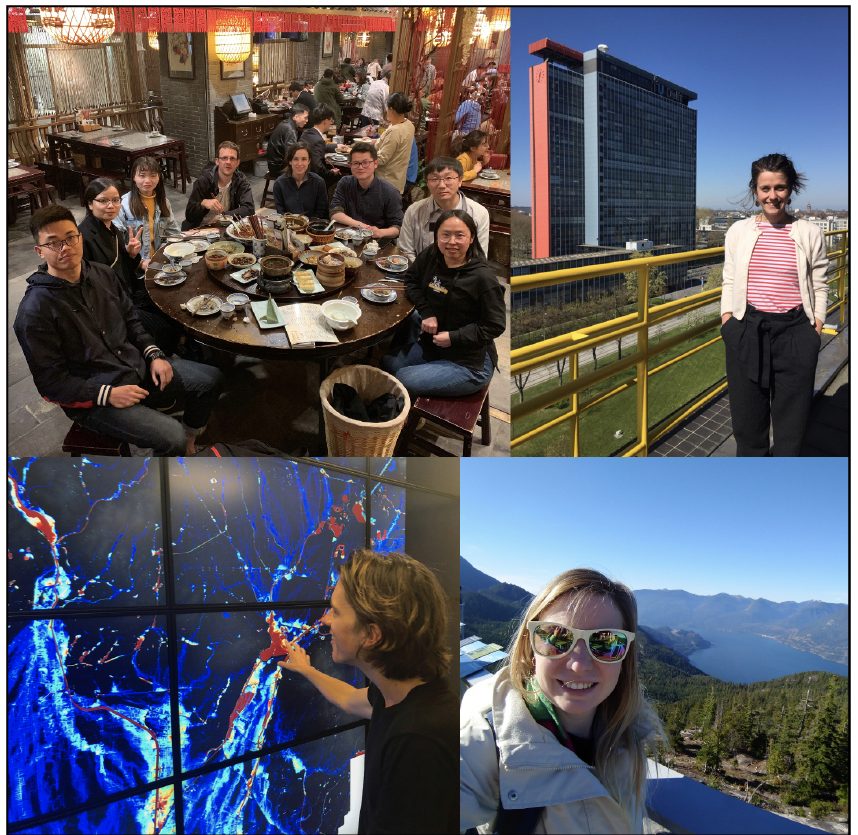
Figure 5. Clockwise from top left: Anna Lo Jacomo (Cohort 2) and Richard Rees (Cohort 3) enjoying the hospitality of their hosts at Hohai University, Nanjing, China; Cohort 2 student Olivia Bailey’s research base at TU Delft, Netherlands; Cohort 2 student Olivia Milton- Thompson making the most of her research visit to UBC, Vancouver, Canada; and Cohort 2 student Joe Shuttleworth at the University of California, Irvine,